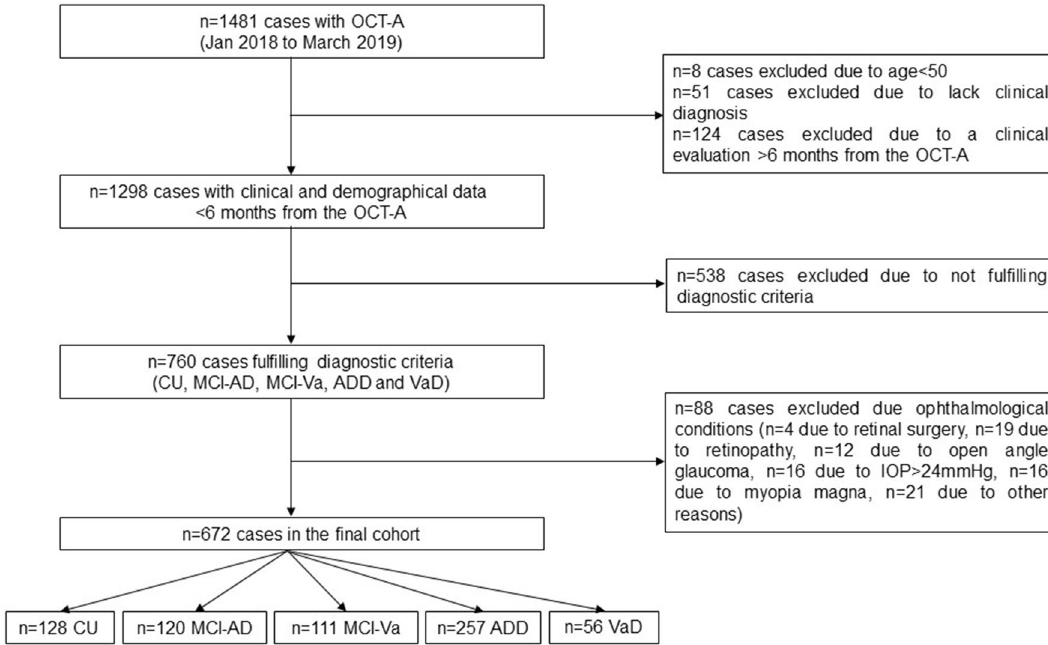
Figure 1. Participants’ selection algorithm. CU = cognitively unimpaired; ADD = probable Alzheimer´s disease dementia; IOP = intraocular pressure: MCI-AD = mild cognitive impairment due to Alzheimer´s